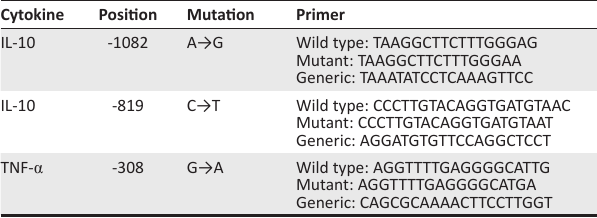
TABLE 1: Wild-type, mutant primer and generic primer sequences for the determination of human interleukin-10 -1082, interleukin-10 -819 C/T and tumour necrosis factor-alpha -308 G/A promoter region